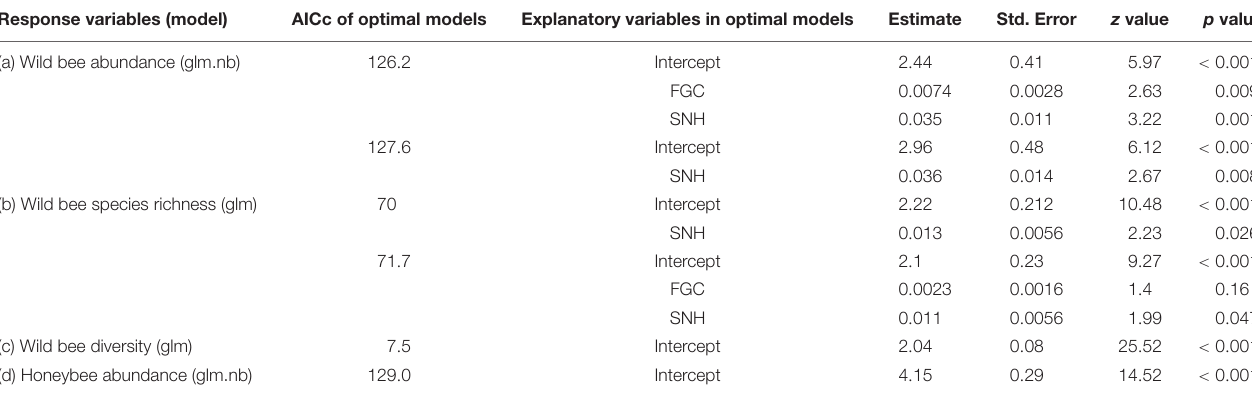
TABLE 2 | Results from general linear models (or those with a negative binomial distribution) indicating the effects of landscape variables, flowering ground cover, and their interaction on the abundance (a), species richness (b), and diversity (c) of wild bees, as well as honeybee abundance (d). FGC = flowering ground cover, SNH = percentage of seminatural